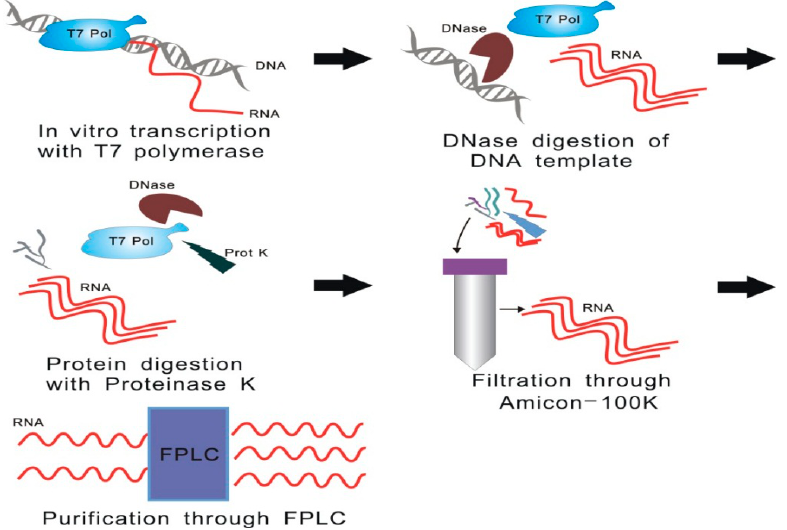
Figure 9. Enzymatic synthesis and purification of lncRNA. T7 RNA polymerase system is used for RNA synthesis, followed by the addition of DNase enzyme for the digestion of DNA template, and by the addition of proteinase K, which is responsible for the proteolysis of enzymes. The desired RNA is obtained by ultrafiltration and purified using size-exclusion chromatography. FPLC: Fast Protein Liquid